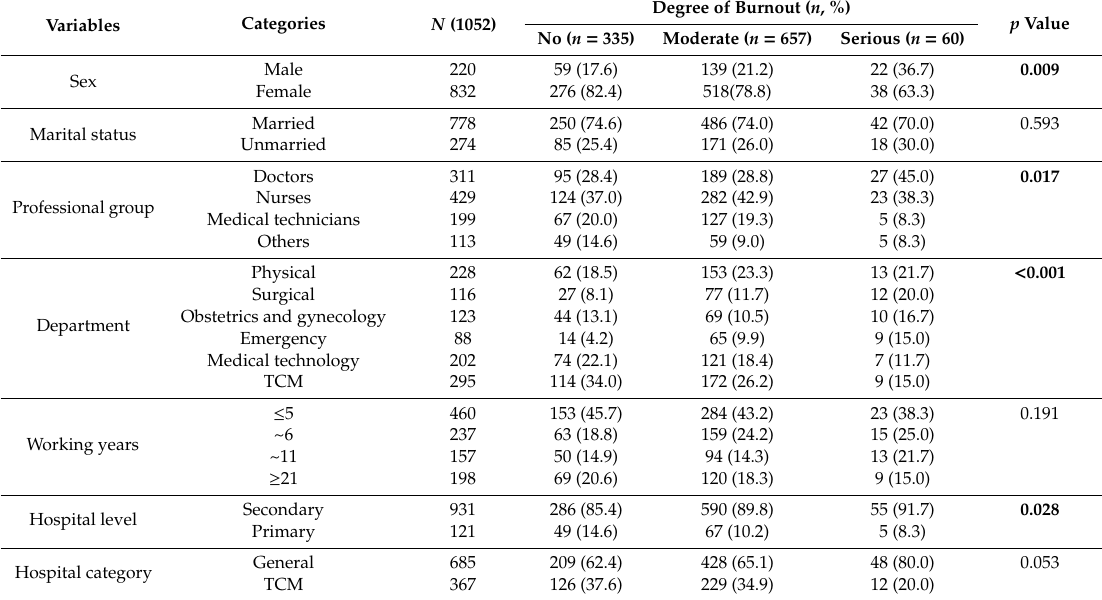
Table 1. Basic characteristics of the included